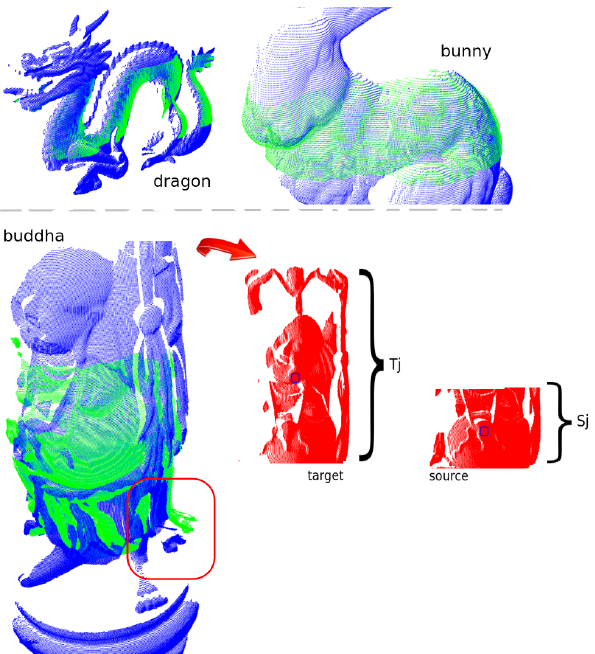
Figure 11. UPS registration corresponding to the case of 50% partial-overlap between source (green colour) and target (blue colour) for the region around the buddha stomach. In red colour, the target and source subclouds selected for the global registration after UPS